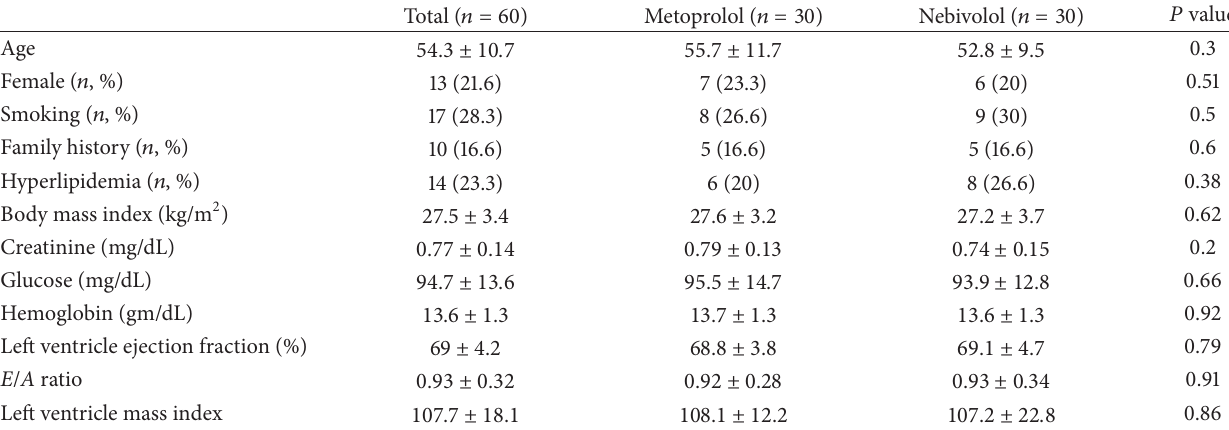
Table 1: Main clinical and laboratory features of the present study population.